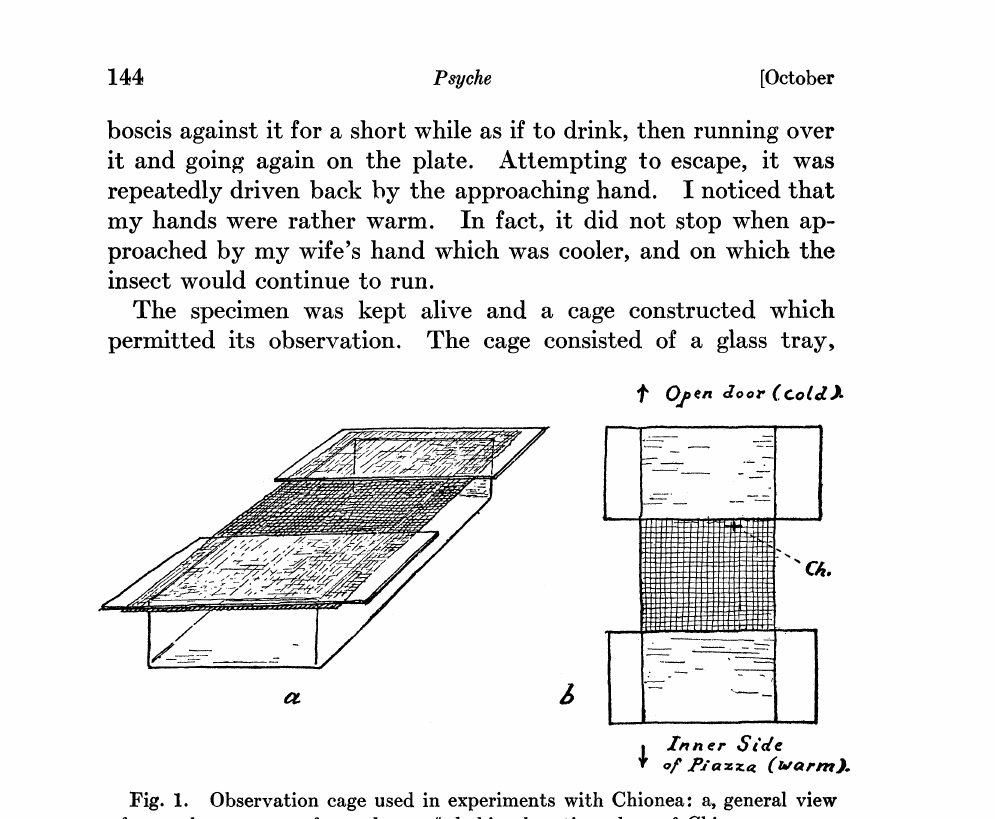
Fig. 1. Observation cage used in experiments with Chionea: a, general view of cage; b, same seen from above; #, habitual resting place of